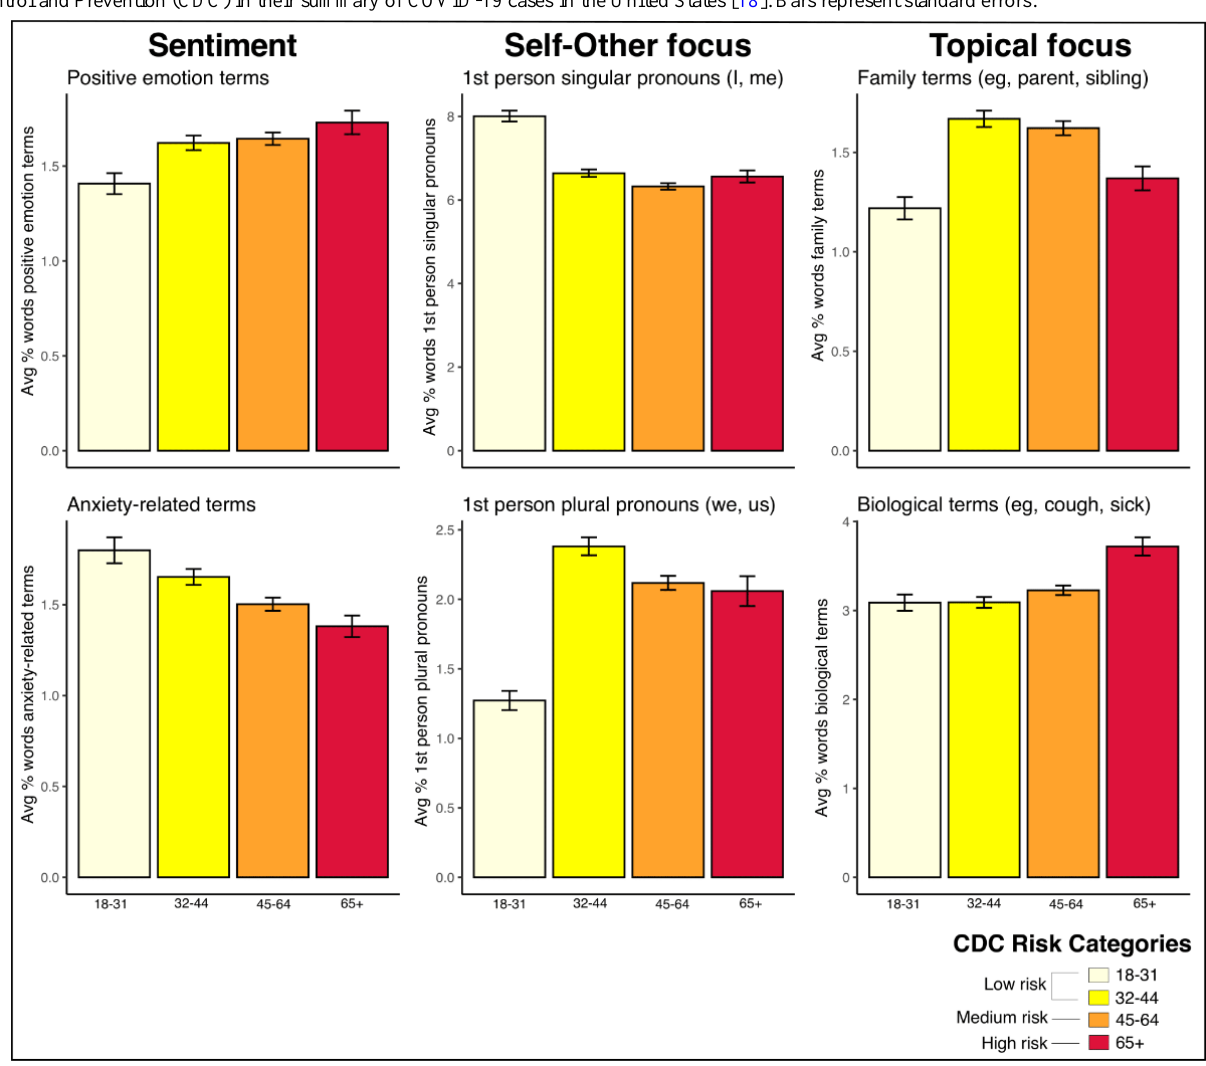
Figure 1. Mean number of words in language categories, by age group. Age groups are modeled after the age groups reported by the Centers for Disease